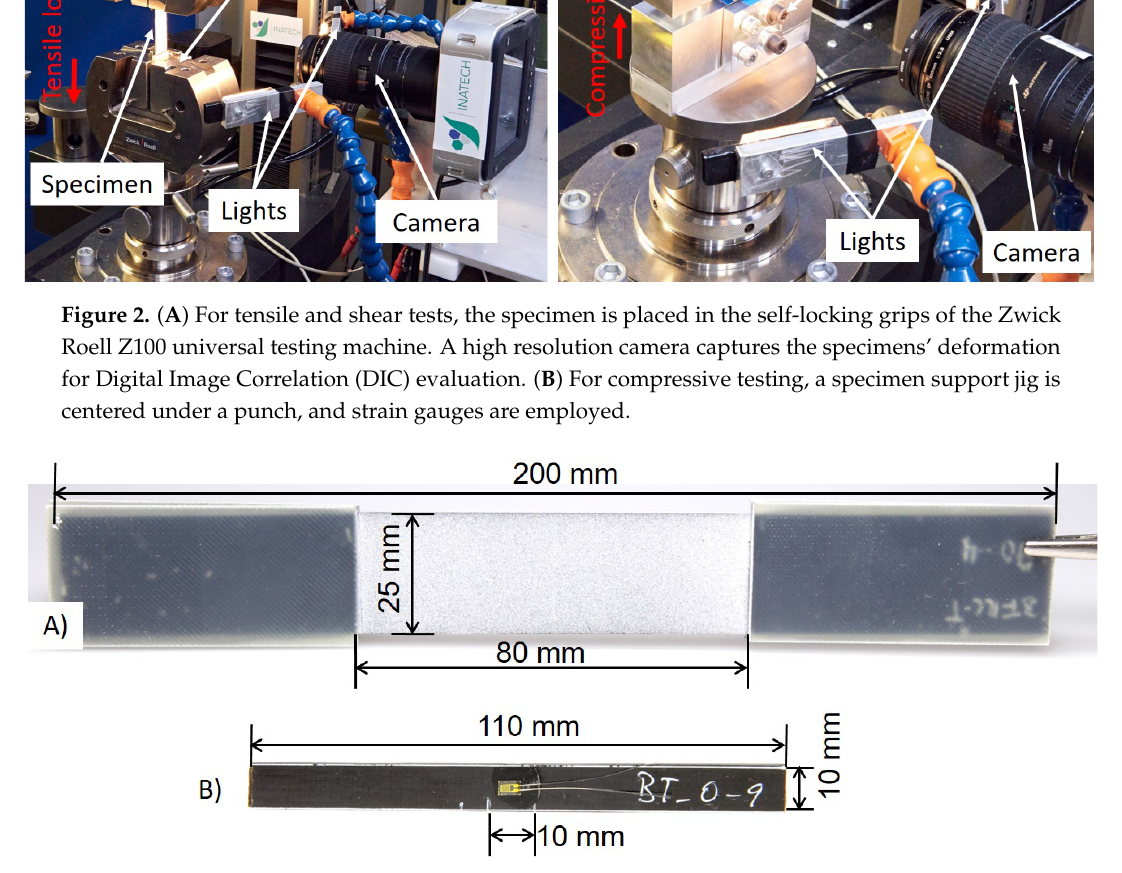
Figure 3. ( A ) Specimen for tensile and shear testing.The gauge section is coated with a fine speckle pattern for Poisson’s ratio estimation. Glass–fiber tabs were bonded at both sides at the grip section. ( B ) Specimen for compressive testing with strain